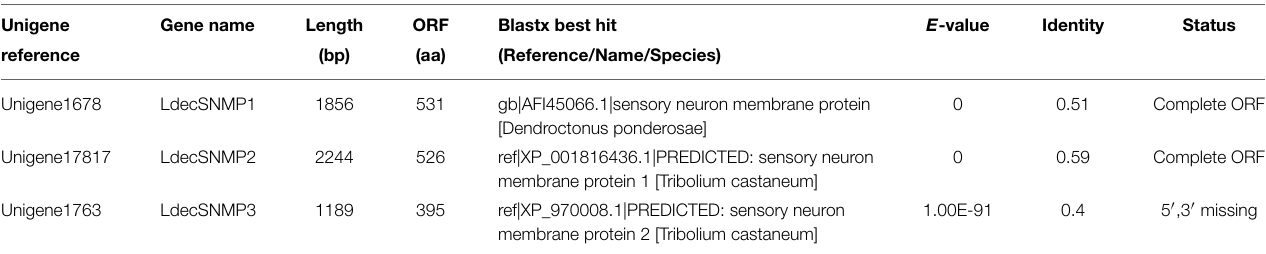
TABLE 4 | Unigenes of candidate sensory neuron membrane proteins.